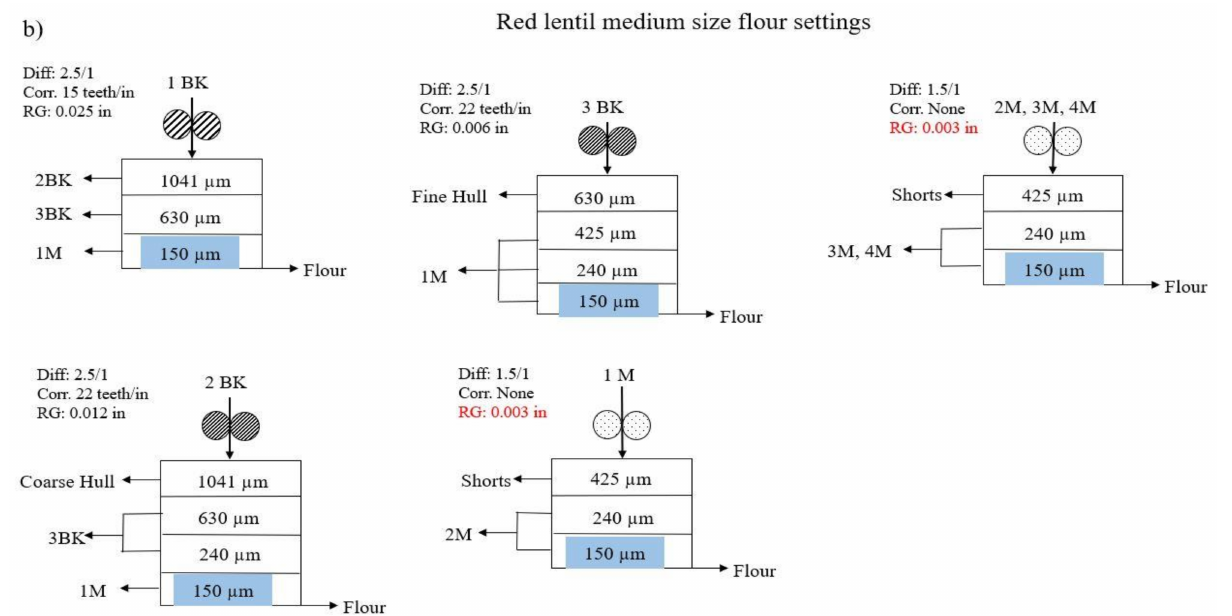
Figure 1. Roller milling flowsheet to obtain ( a ) small red lentil flour ( ≤ 75 µ m), ( b ) medium red lentil flour ( ≤ 150 µ m), and ( c ) large red lentil flour ( ≤ 200 µ m); (Diff—Differential speed; Corr—Corrugations; RG—Roller Gap; BK—Break,